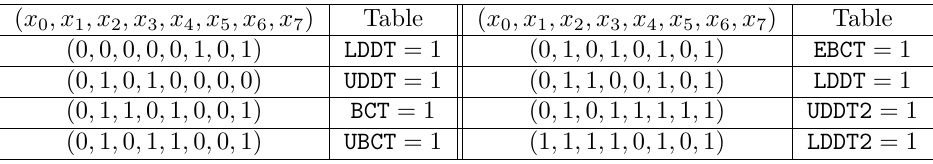
Table 8: Constraints of the upper/lower boundary: Sum [ r x ] = P